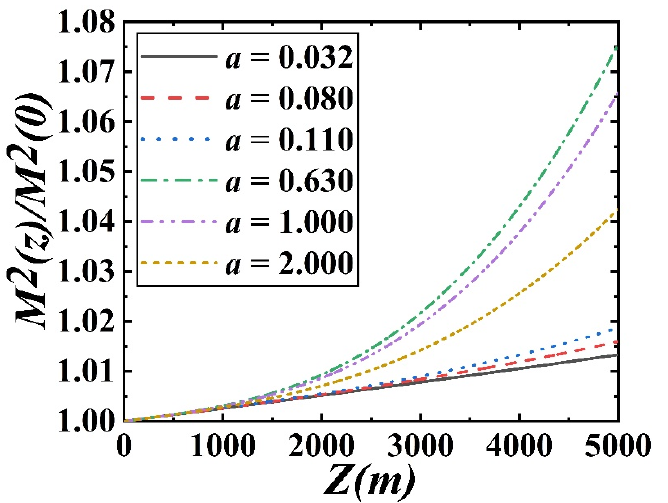
Figure 6. Dimensionless quantity M 2 ( z ) / M 2 ( 0 ) of a partially coherent Airy beam in non-Kolmogorov turbulence versus propagation distance for different a .